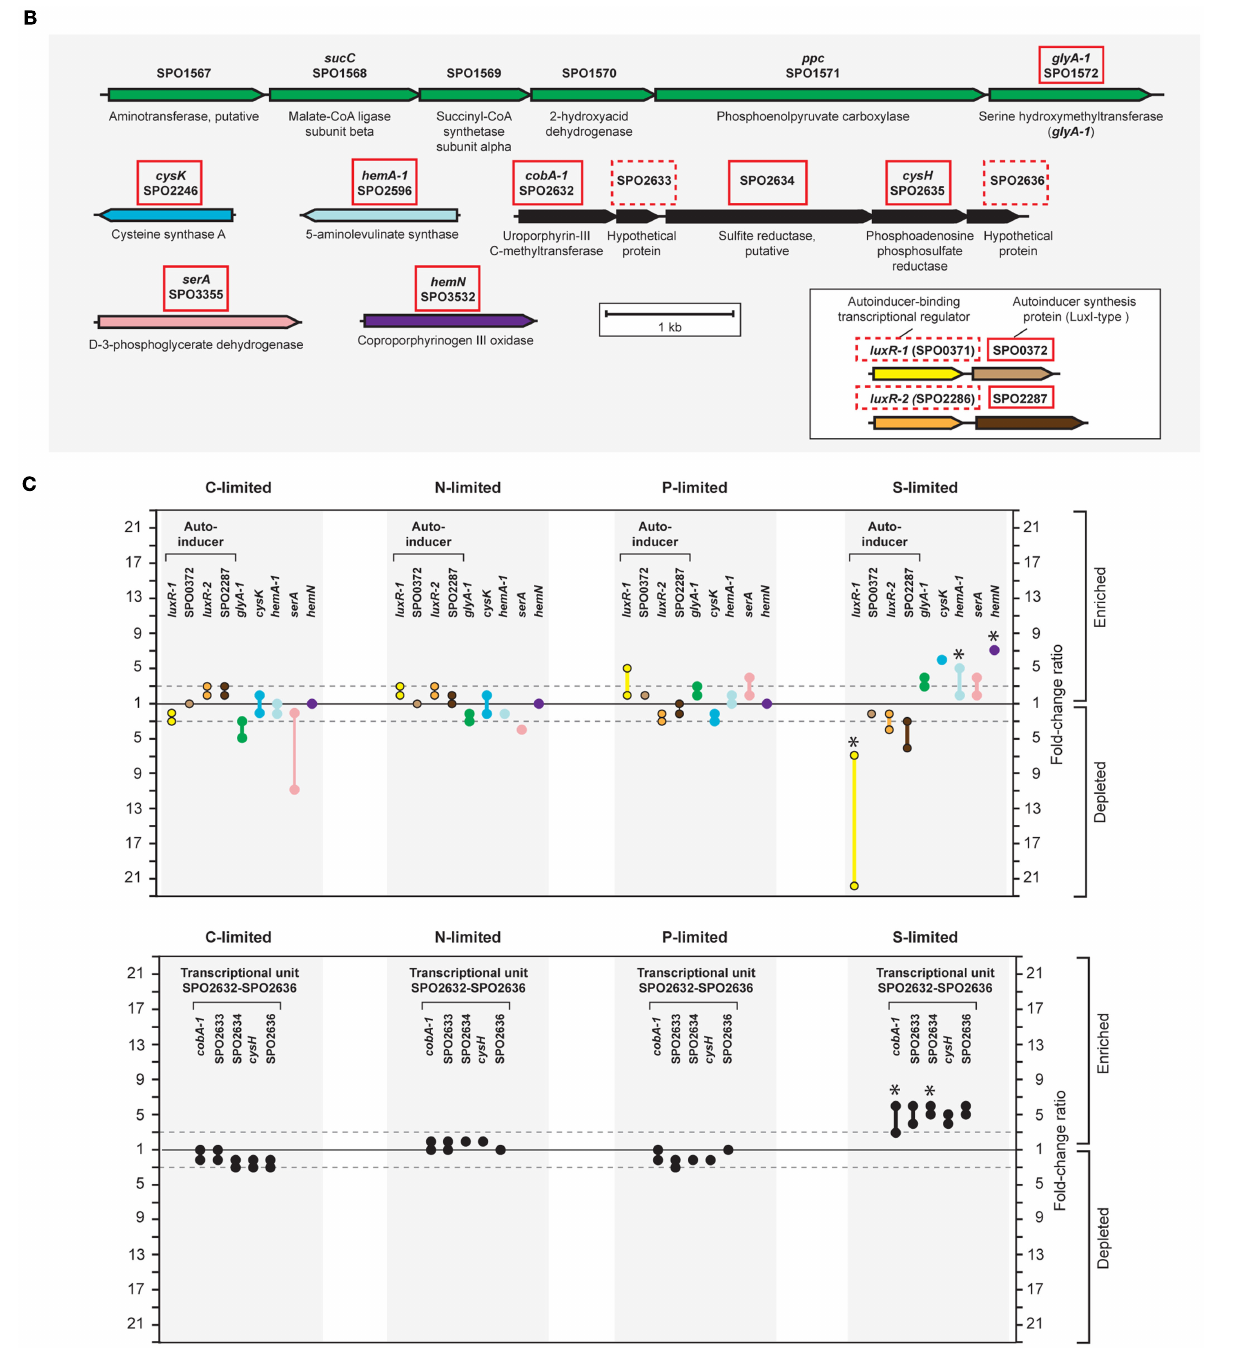
FIGUREA4 | Relevant S-genes in R. pomeroyi DSS-3. (A) Pathway inferred from BioCyc; (B) arrangement of relevant genes on the chromosome; (C) transcriptional ratios for relevant genes; ratios are shown for genes listed in the pathway (A) (solid red box) and genes that are not in the pathway, but are located in proximity to relevant S-genes [dotted red box in (B) ]. Genes located in the same operon are identically color-coded.Two